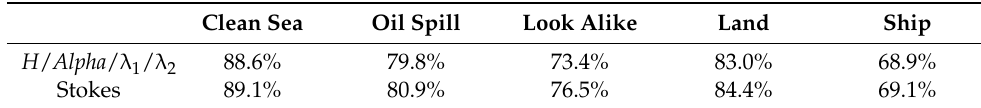
Table 9. Characteristics of polarized parameters in